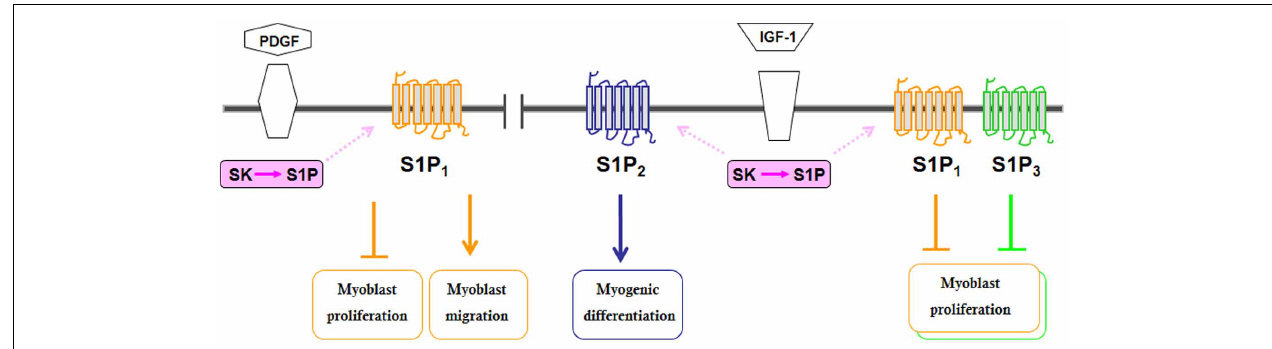
FIGURE 1 | Schematic diagram of the biological actions evoked by S1PR transactivation by some growth factors in C2C12 myoblasts.